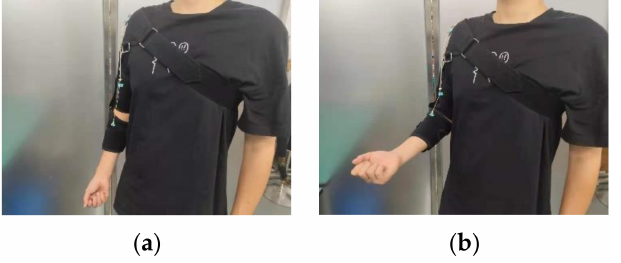
Figure 18. Flexible exoskeleton wearing experiment. ( a ) Extension state. ( b ) Flexion state.